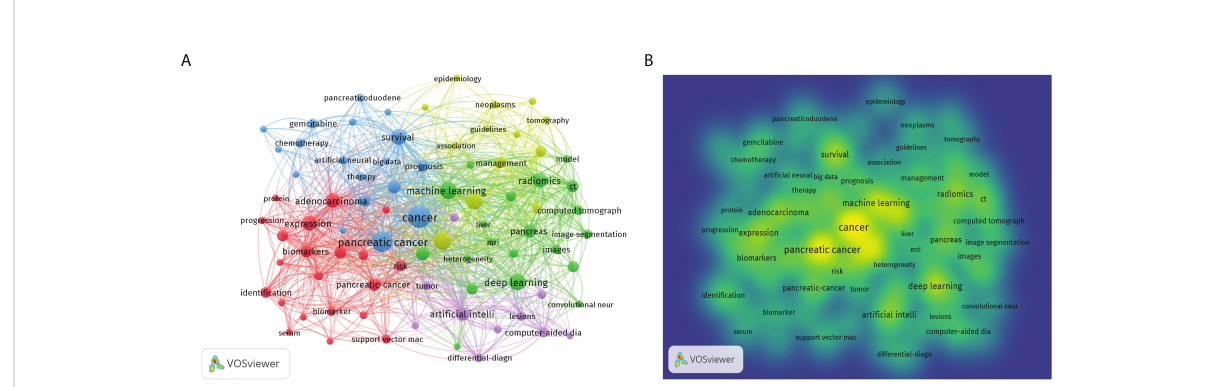
FIGURE 6 Bibliometric analysis of keywords by VOSviewer. (A) Map of Clusters based on keywords analysis. The size of the circle indicated occurrences of the keywords, different colors indicated the variety of clusters. (B) Keywords density visualization map. Different colors represented the frequency of keyword occurrences, and yellow indicated the highest